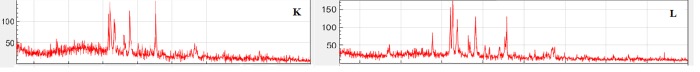
X-ray diffraction analysis (XRD) of synthesized SNPs (K) L. coccineus aqueous nano extract, (L) M. lutea aqueous nano extract.